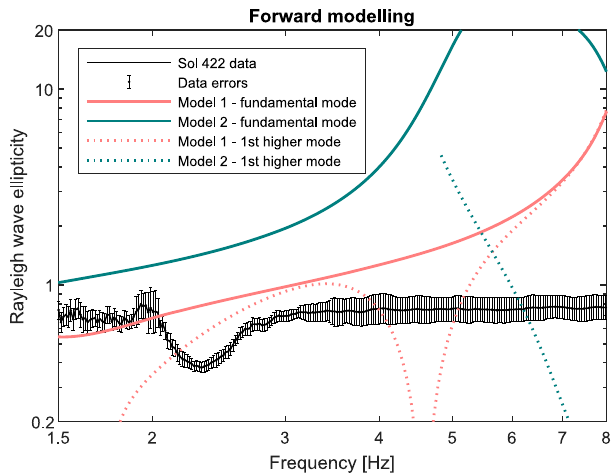
Fig. 4 Extracted Rayleigh wave ellipticity curve compared with modeling results for pre-mission near-surface seismic models. The thick black line shows the Rayleigh wave ellipticity curve extracted for a 7-h duration time window in the evening of sol 422/423 (see Fig. 2). The vertical bars show the estimated data errors. Note that the errors were manually increased for the frequency range around 2 Hz that is known to be affected by monochromatic electronic cross-coupling noise 39 . Ellipticity curves for the fundamental and fi rst higher Rayleigh wave modes computed for the two velocity models are shown in red and blue, respectively (models 1 and 2; Tables 1 and 2). Note that neither of the modeled Rayleigh wave ellipticity curves is able to explain the observed trough at 2.4 Hz. Table 1 Simpli fi ed near-surface reference model (referred to as model 1; loosely based on Knapmeyer-Endrun et al. 24,25,45 ).